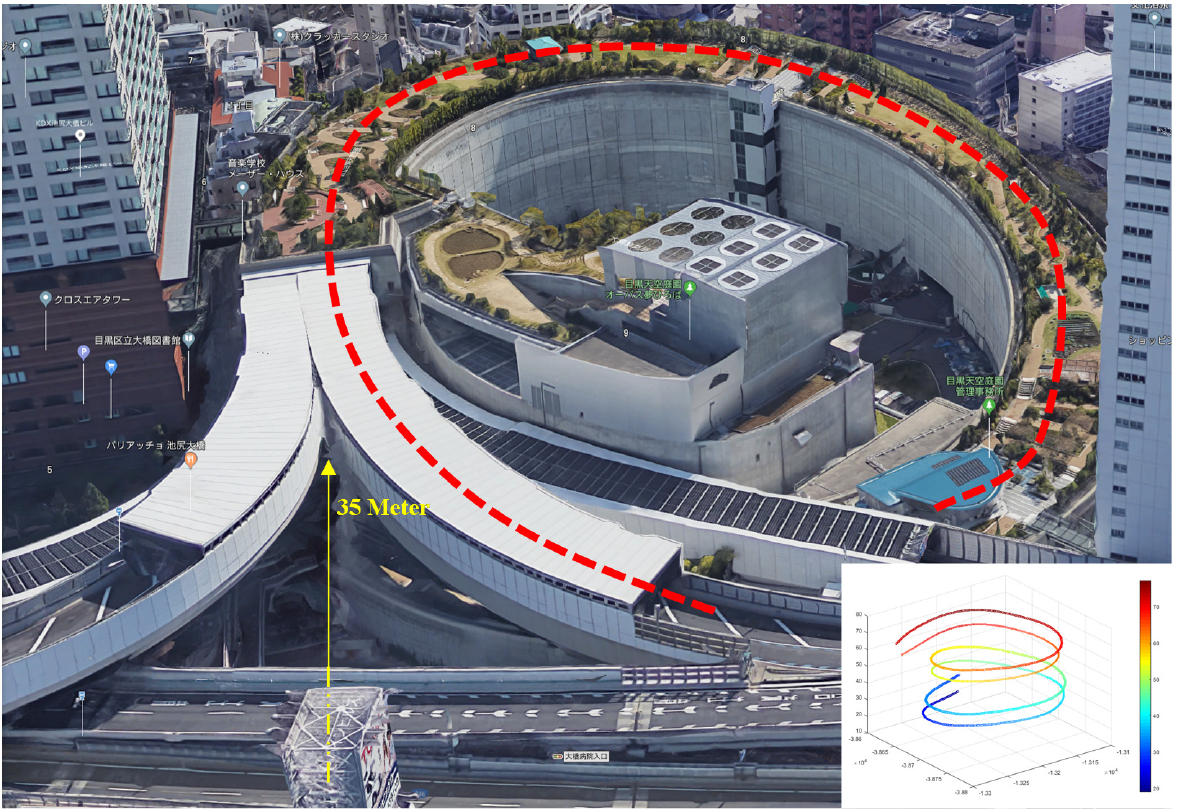
Figure 9. Ohashi junction. The 35 m closed sky part aboveground with two driven upward and downward trajectories. The red dotted line demonstrates the vehicle trajectory in the forth loop.